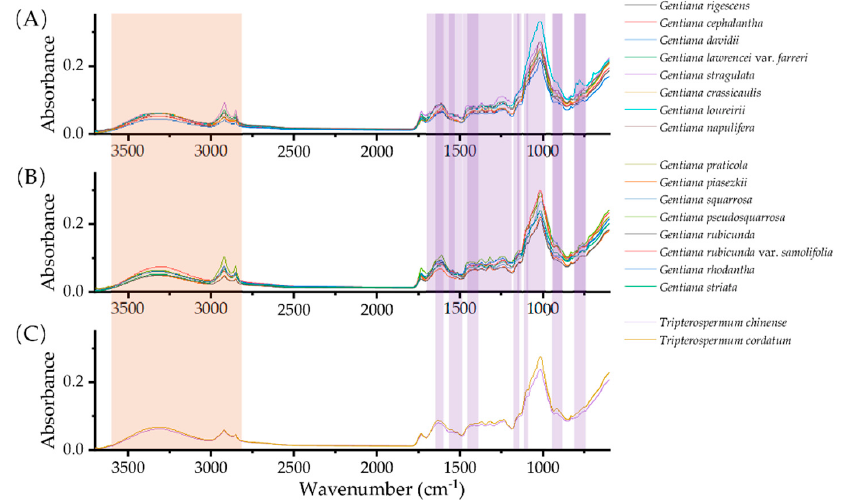
Figure 3. Averaged FT-MIR spectra of 18 Gentiana ( A ), ( B ), and Tripterospermum species ( C ).